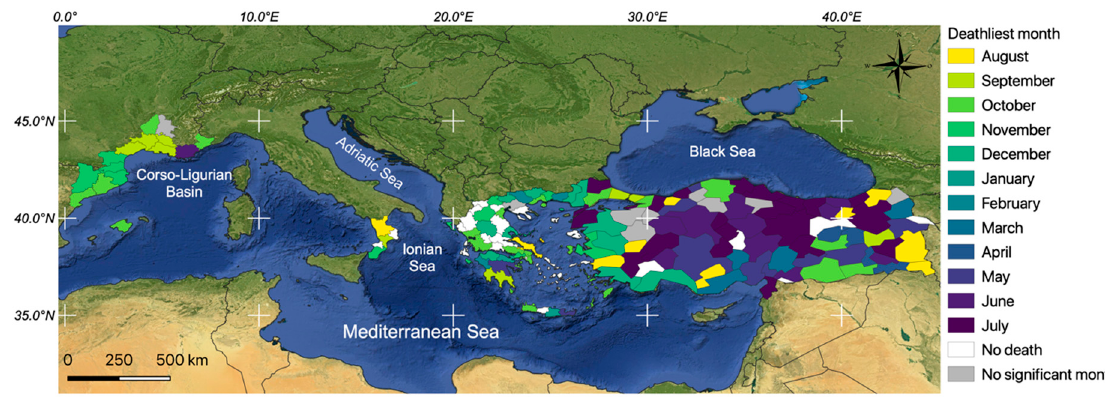
Figure 13. Deadliest month by NUTS 3 region.